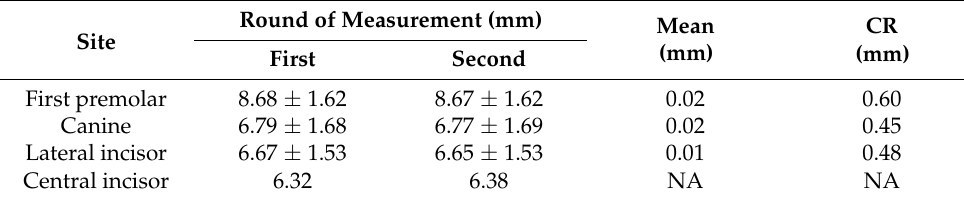
Table 5. Variability in measurement of distance between the MIC and the inferior cortical